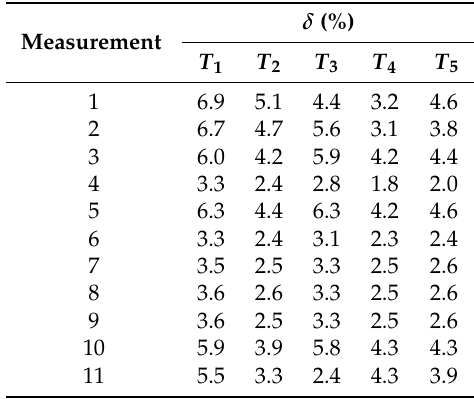
Table 2. Average relative deviation of system of indirect temperature measurement (SIMT) for laboratory measurement.